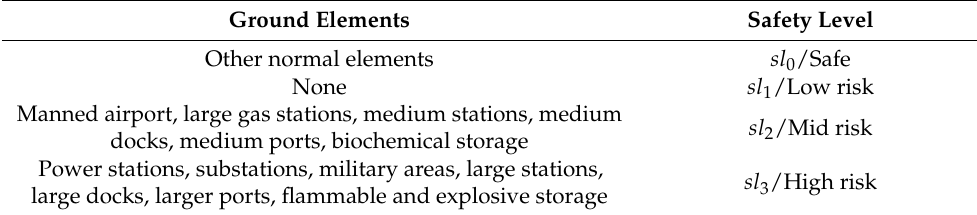
Table 4. Ground elements classification.